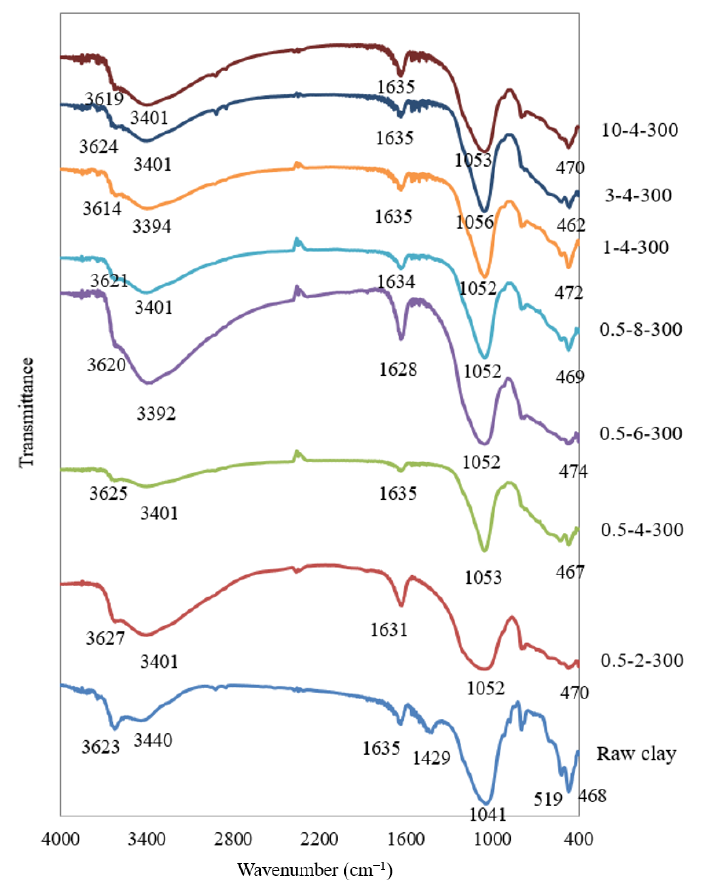
Figure 14. FTIR spectra of raw clay in comparison with the titanium-pillared clays.